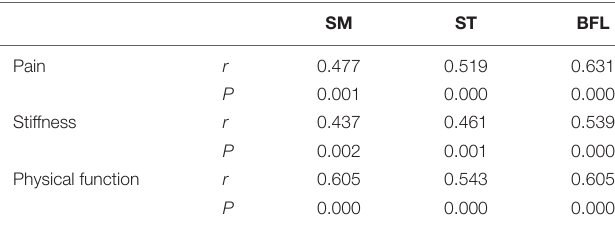
TABLE 4 | Correlation between the three hamstring shear modulus and WOMAC score in the observation